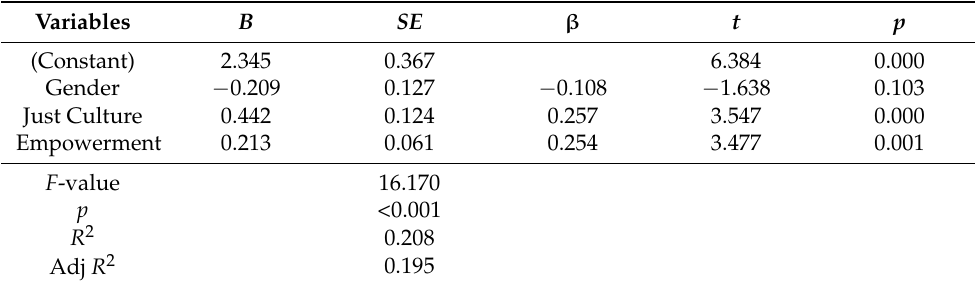
Table 4. Factors Influencing Patient Safety